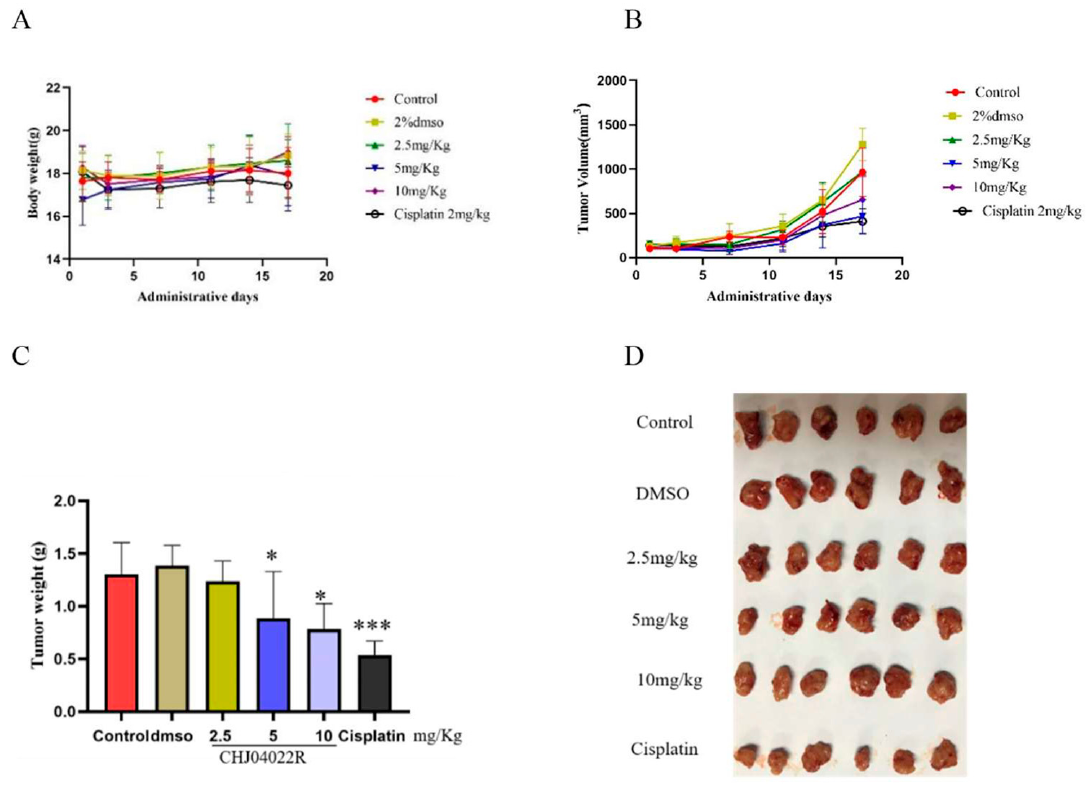
Figure 6. ( A ) The antitumor effect of CHJ04022R on the tumor growth of A375 cells in vivo. ( B ) Changes in the body weight of mice. ( C ) Changes in the tumor weight of mice. ( D ) Repre- sentative photographs of tumors, tumor weights and tumor volumes. * p < 0.05, *** p < 0.001 compared to the control